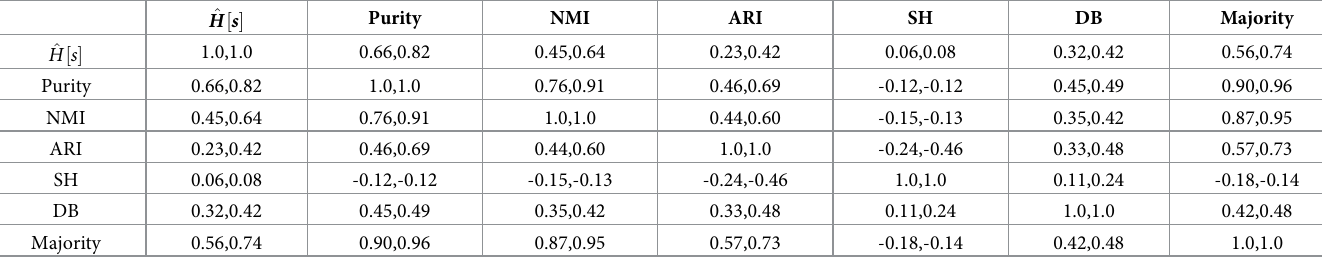
Table 7. Kendall’s τ and Spearman’s correlation result for Red Wine.